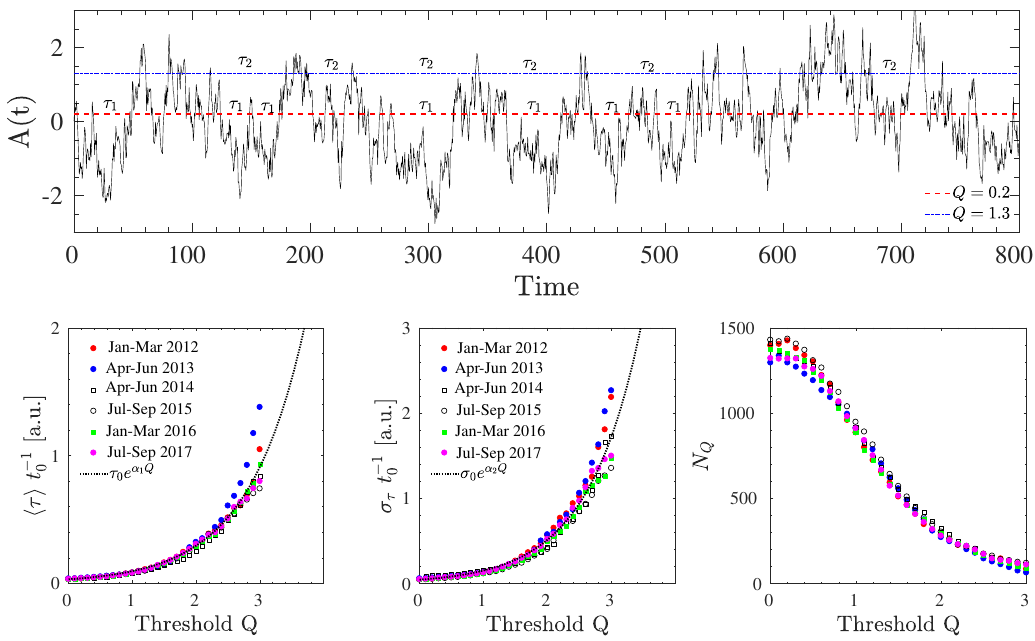
Figure 7. Upper panel : Sample illustration of the interoccurrence times (IOT) τ i obtained from a synthetic data set A ( t ) . Horizontal dashed lines represent the selected threshold Q in the data. By increasing Q , two sets of IOT τ 1,2 can be identified in the data, characterized by an increasing average (cid:104) τ (cid:105) and standard deviation σ τ , respectively. Lower panels : Average IOT duration (cid:104) τ (cid:105) ( left panel ) i and standard deviation σ τ ( central panel ) as a function of the threshold Q normalized to the large eddy turnover t 0 , for different samples. Dotted lines indicate the exponential behavior of (cid:104) τ (cid:105) and σ τ , respectively, (cid:104) τ (cid:105) = τ 0 exp ( 1.13 Q ) and σ τ = σ 0 exp ( 1.21 Q ) . The right-hand panel shows the dependence of the total number of IOTs, N Q measured at different thresholds Q